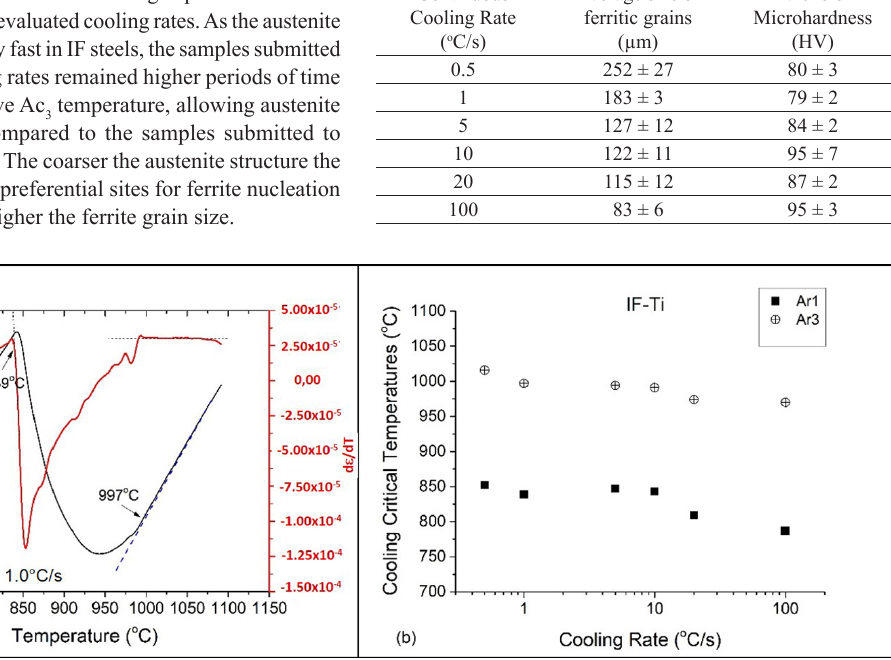
Figure 3. (a) Example of cooling dilatometric curve obtained for a continuous cooling rate at 1 o C/s; (b) cooling critical transformation temperatures as a function of applied cooling rates.